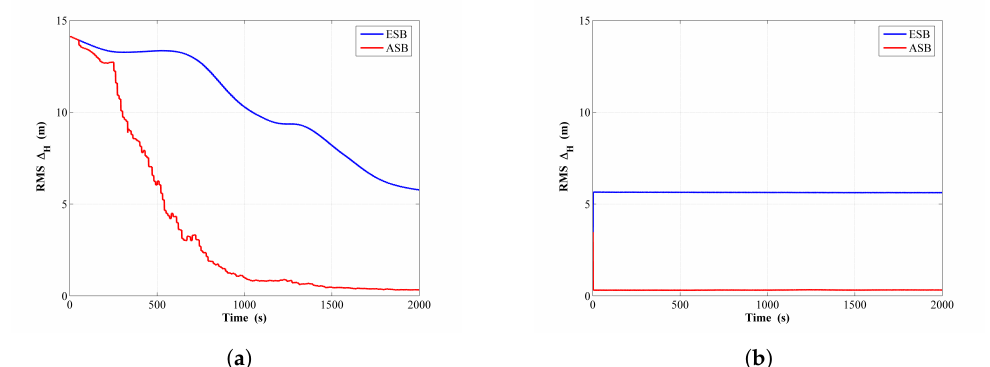
Figure 2. RMS of Horizontal distance error comparison between the ESB and the ASB algorithms using simulation data with unknown R k : ( a ) Filter; ( b ) RTS smoother.